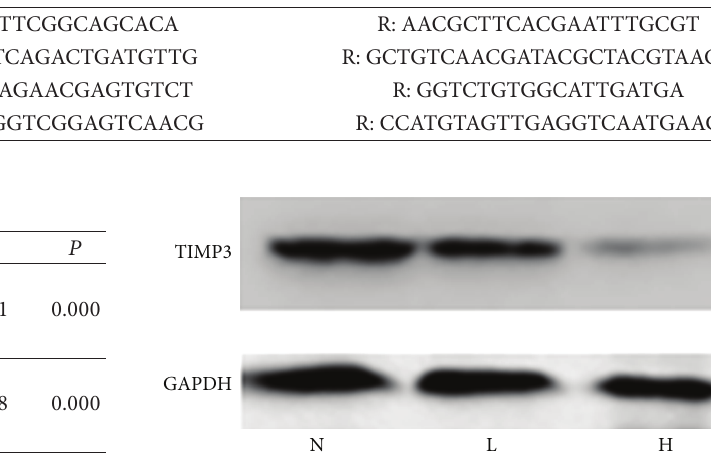
Figure 1: Western blot electrophoresis results, N: normal group, L: low invasion and metastasis group, H: high invasion and metastasis group;itcanbeseenthatTIMP3proteinexpressionwassignificantly decreased in high invasion and metastasis